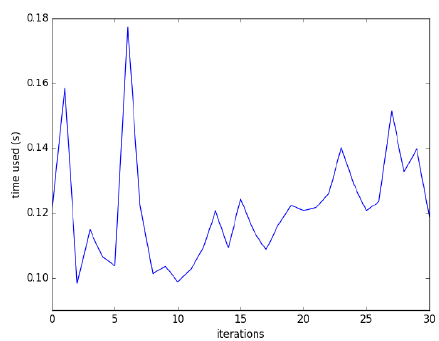
Figure 17. The time used for the LSTM algorithm to output the prediction, at each iteration/time